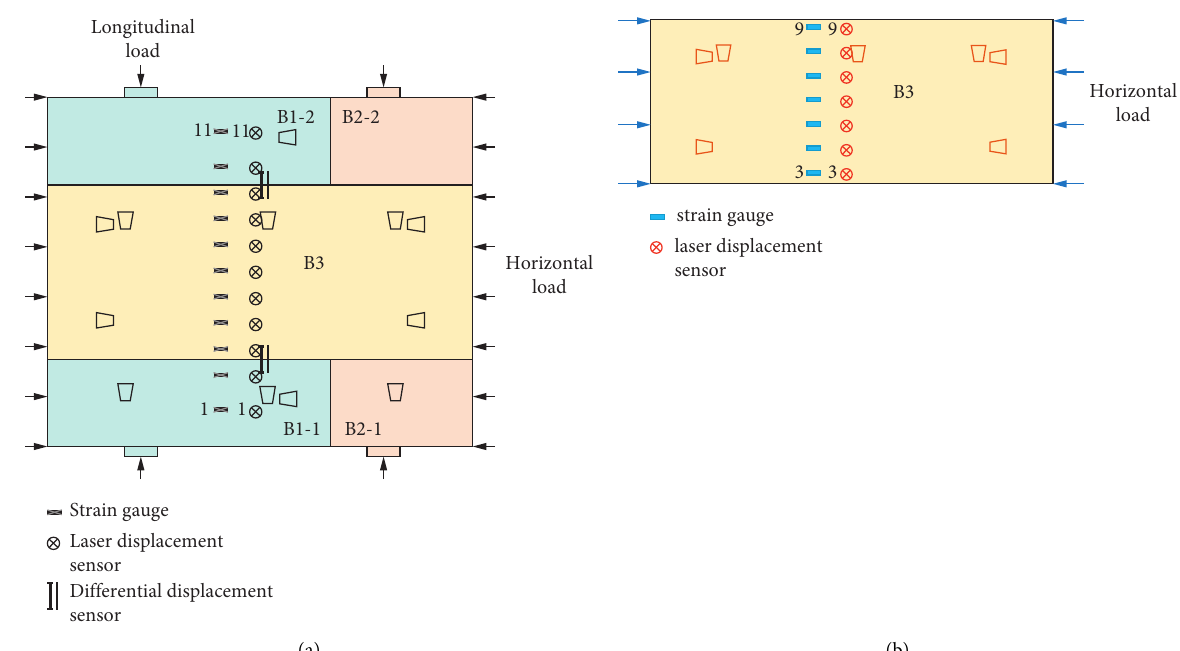
Figure 6: Measuring points of segments. (a) Measuring points of combined segments. (b) Measuring points of single segment.